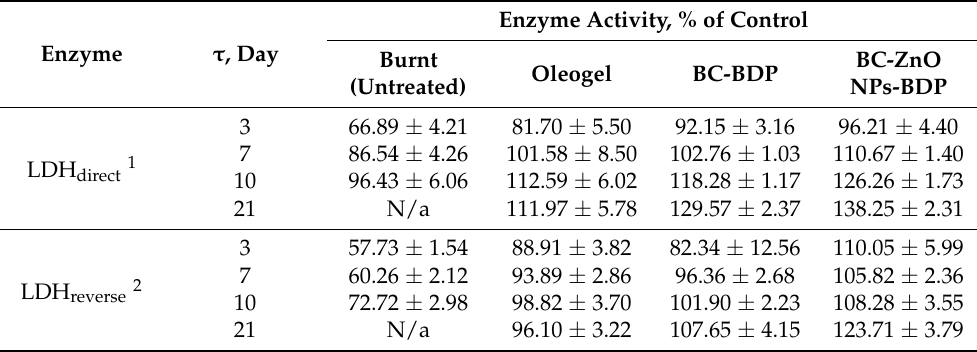
Table 4. The specific activity of lactate dehydrogenase in direct and reverse reactions under the action of the studied drugs (% of control), n = 3, p <